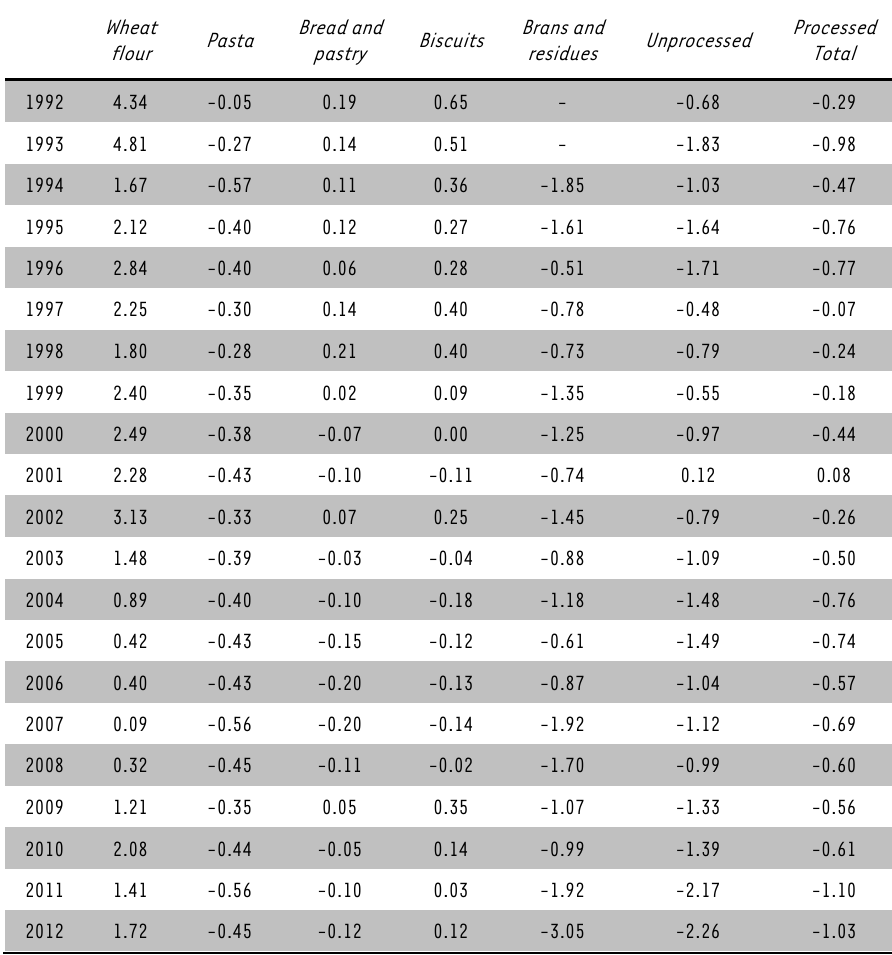
Processed Total